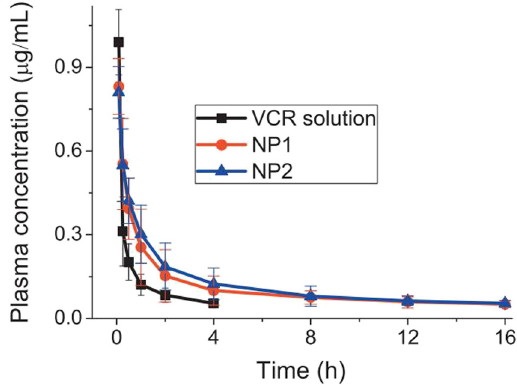
Figure 1: Mean plasma concentration – time pro fi les of vincristine in rats ( n = 6 ) after a single intravenous injection of F - VCR solution and VCR - loaded nanoparticles ( NP1 and NP2 ) suspension at the dose of 1.2 mg of VCR/kg, respectively [ 33 ]